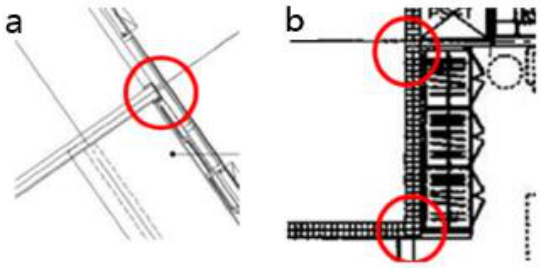
Figure 4. Corners of the wall: ( a ) corner type a; ( b ) corner type b.